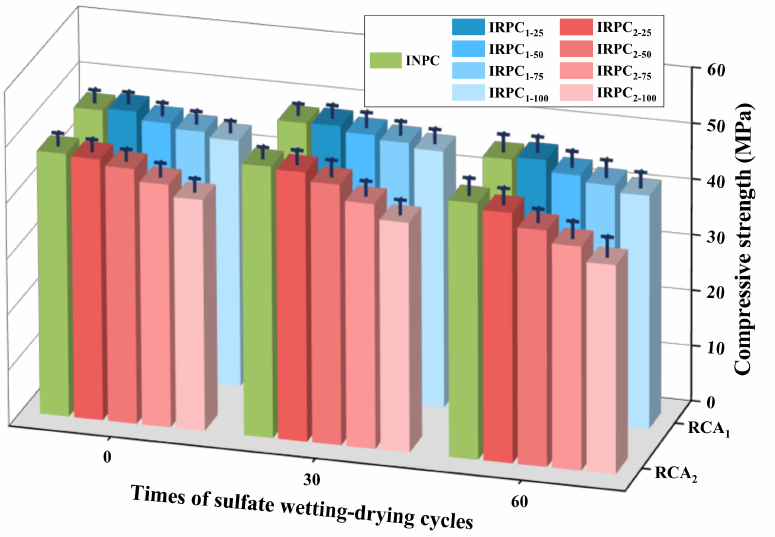
Figure 4. Compressive strength of IRPC with variable replacement rates after different sulfate wetting-drying